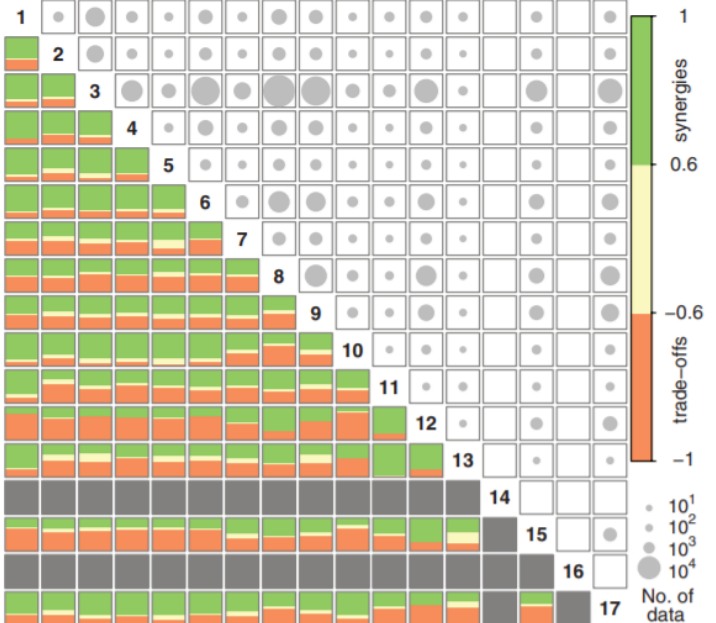
Note : The color bars represent the shares of synergies (green), nonclassifieds (yellow), and trade-offs (orange) observed between the SDG pairs for the entire dataset. The gray bar depicts insufficient data. The area of the circle in the boxes indicates the number of data pairs (see the legend for comparison). The SDGs are represented by the numbers in the diagonal Source : Pradhan et al.